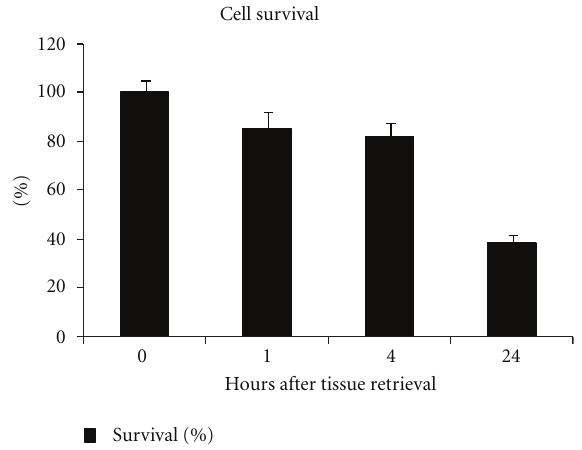
Figure 5: Murine ex vivo tissue survival in DMEM over time. Murine thigh muscle was harvested immediately after culling, immersed in DMEM, and stored at 37 ◦ centigrade. Cell survival was assessed at 0, 1, 4, and 24 hours with 38% viability at 24 hours when compared to 0